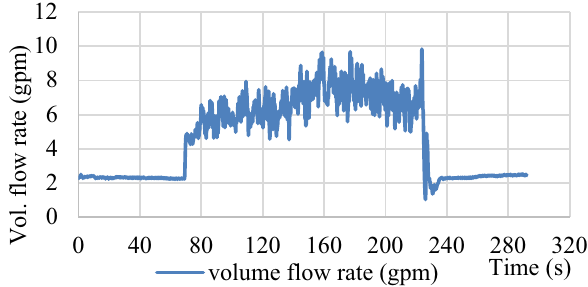
Fig. 17 Kick effects on rotary speed—no-kick region #1 for Run_1